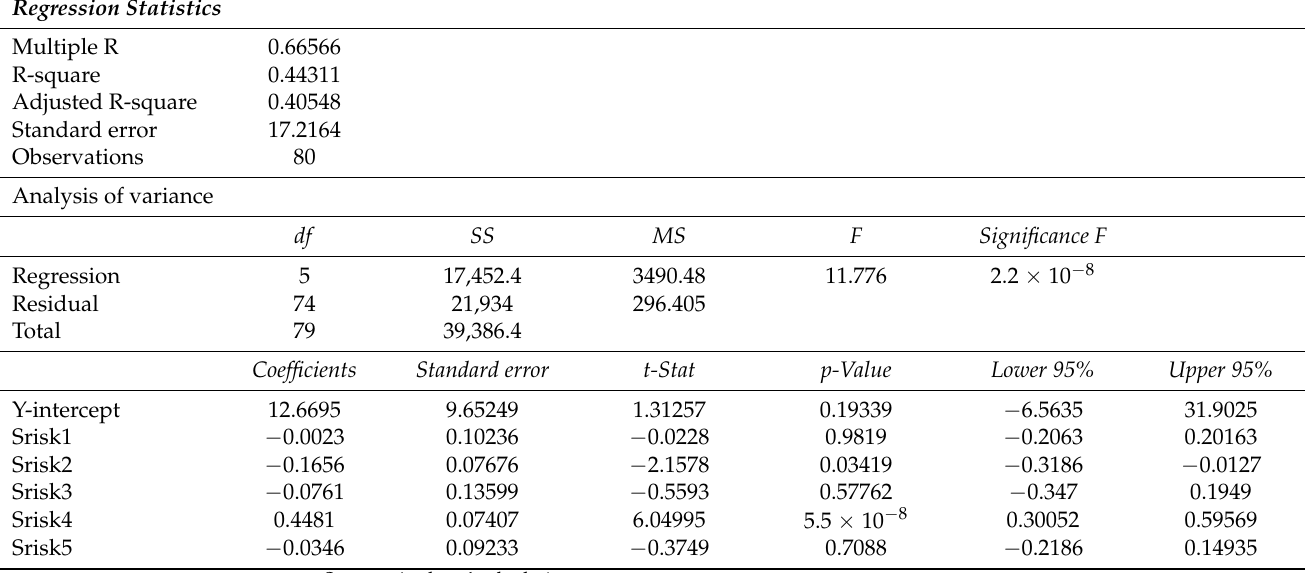
Table A12. Regression statistics of the dependence of Frisk 3 on social consequences of investments in innovation